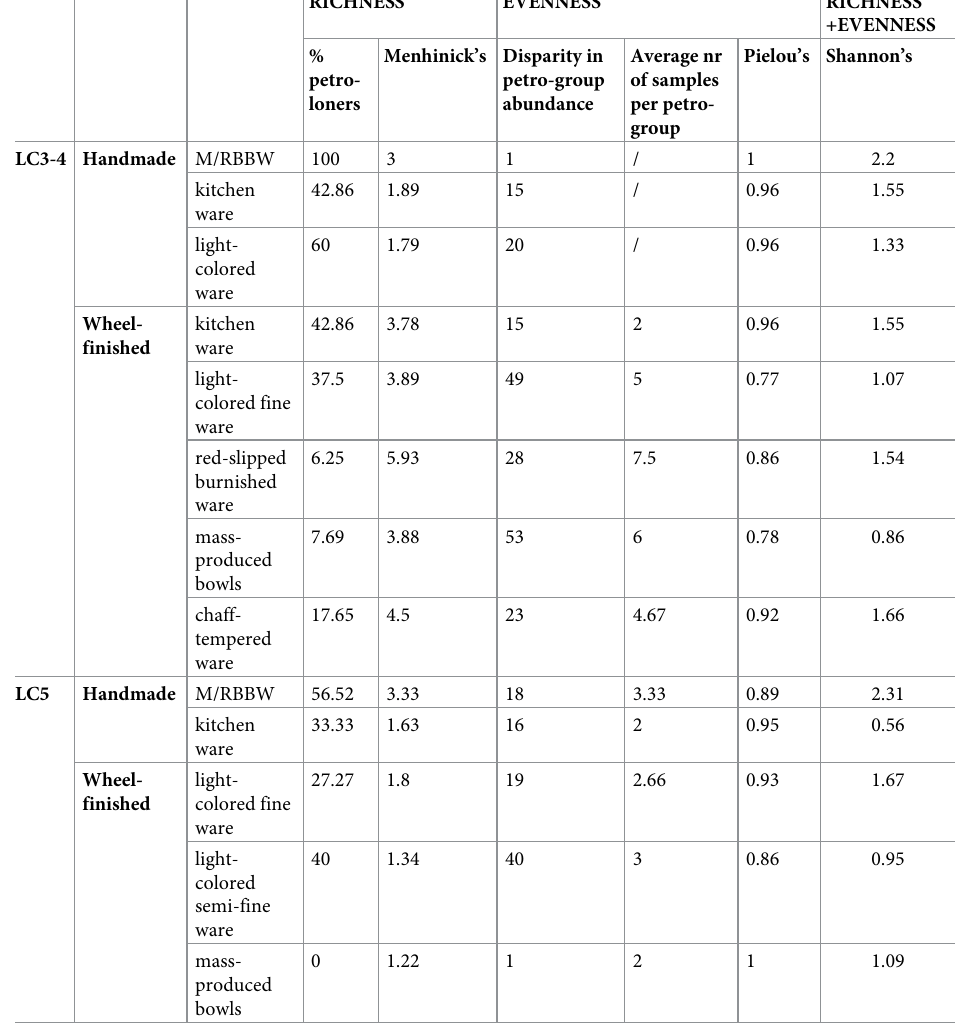
Table 12. Values of the diversity parameters considered for the different handmade and wheel-finished ceramic wares of the LC3-4 and